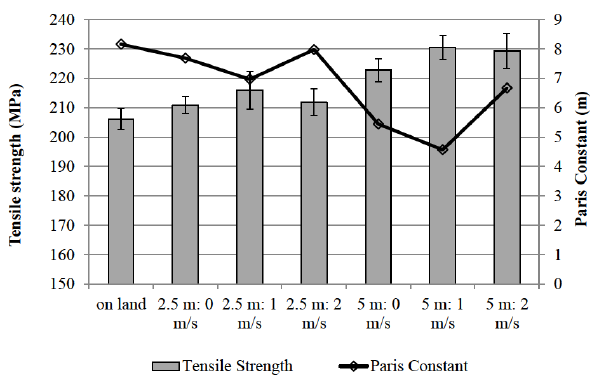
Figure 15: Relationship between tensile strength and Paris